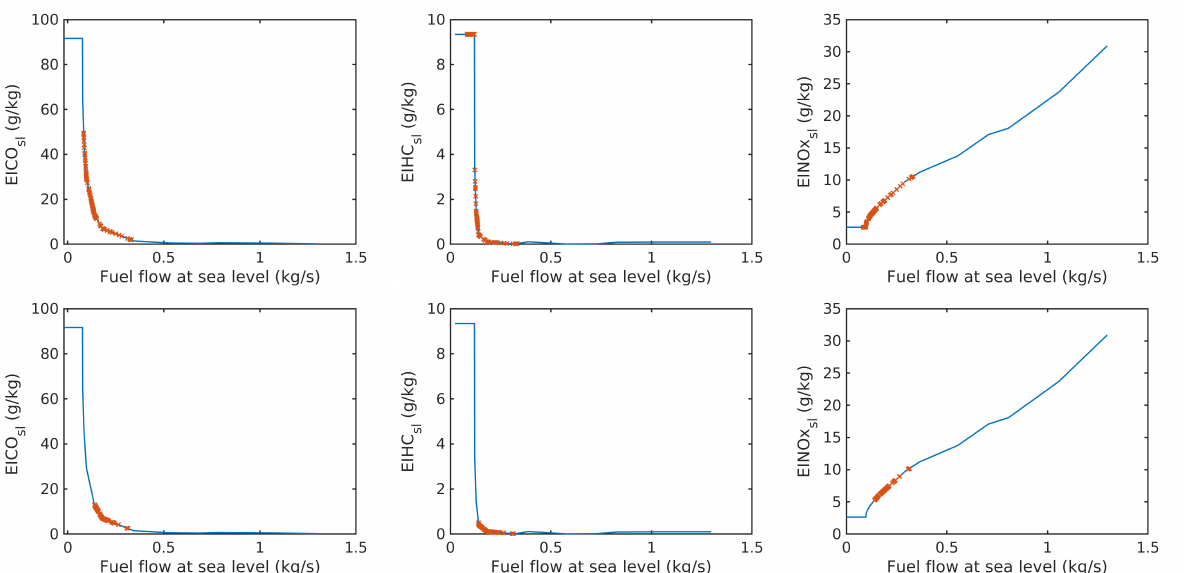
Figure 17. Emissions indices at sea level with respect to fuel flow at sea level for the simulated FDR1 descent trajectory: original ( top ) and optimized ( bottom ).